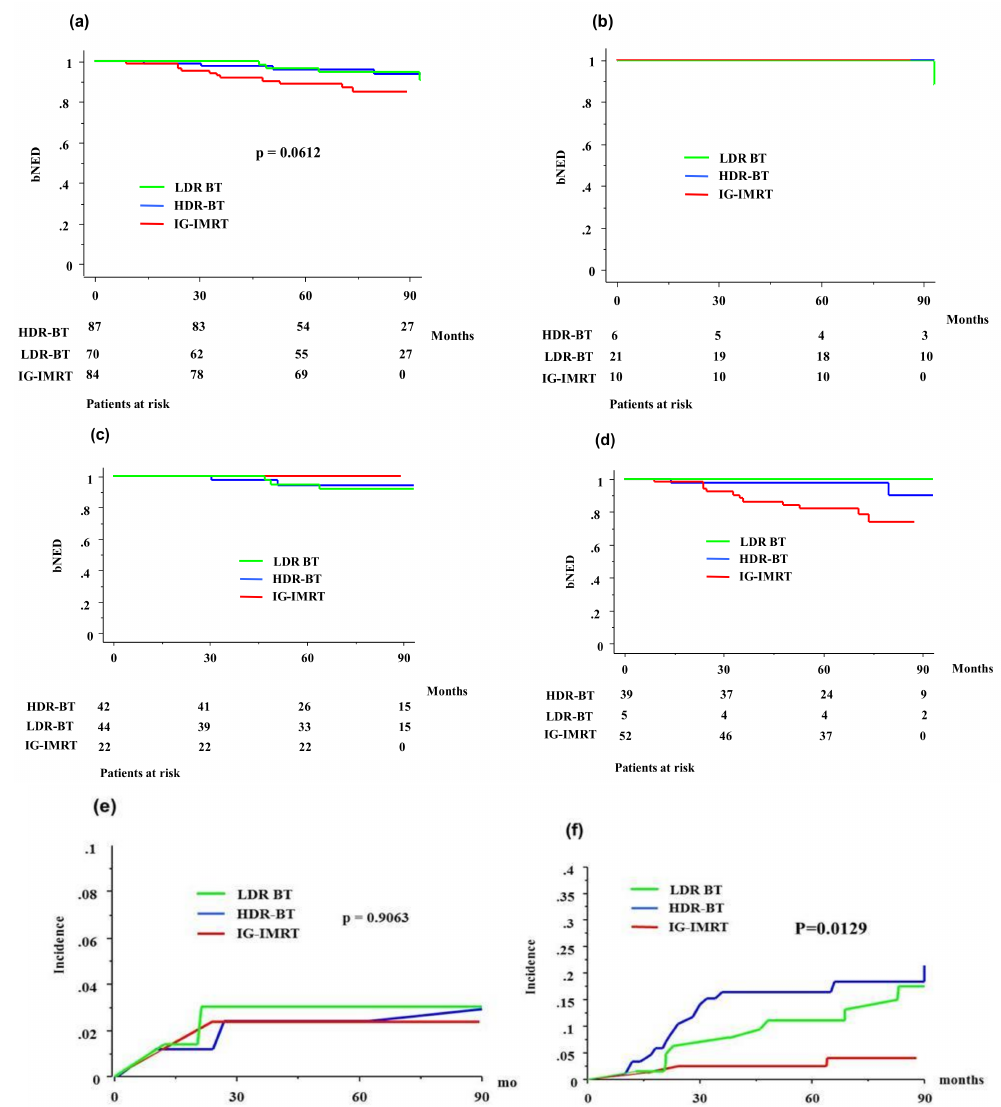
Figure 3. Biochemical control rates and accumulated incidence of grade ≥ 2 toxicity among IG-IMRT, high-dose-rate BT (HDR-BT), and low-dose-rate BT (LDR-BT) in elderly patients: ( a ) total population; ( b ) low-risk group; ( c ) intermediate-risk group; ( d ) high-risk group; ( e ) accumulated incidence of gastrointestinal toxicity grade ≥ 2; ( f ) accumulated incidence of genitourinary toxicity grade ≥ 2. bNED = no biochemical evidence of disease. Table 6. Late toxicities according to modalities in elderly.